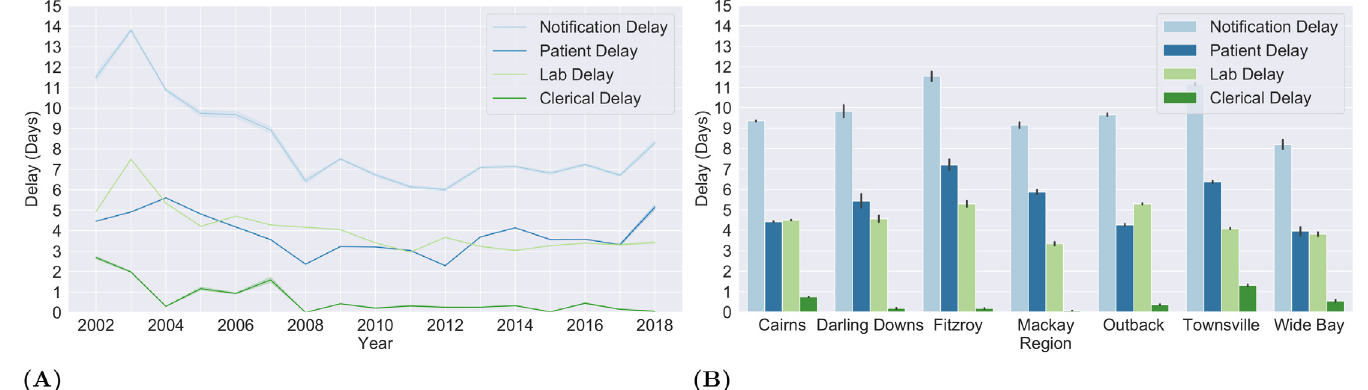
Fig 4. Notification delay and its components. A temporal (A) and spatial (B) depiction of notification delay and its components for the dengue cases reported in the vector present regions of Queensland, Australia. The cases are grouped by the year and region (SA4) of occurrence, respectively. The patient delay is the time elapsed (in days) since the onset of symptoms to the date of specimen collection. The time taken by a laboratory from the date of specimen collection to the date of diagnosis is called the laboratory delay. And, the time elapsed between the date of diagnosis and the date of notification is called clerical delay.